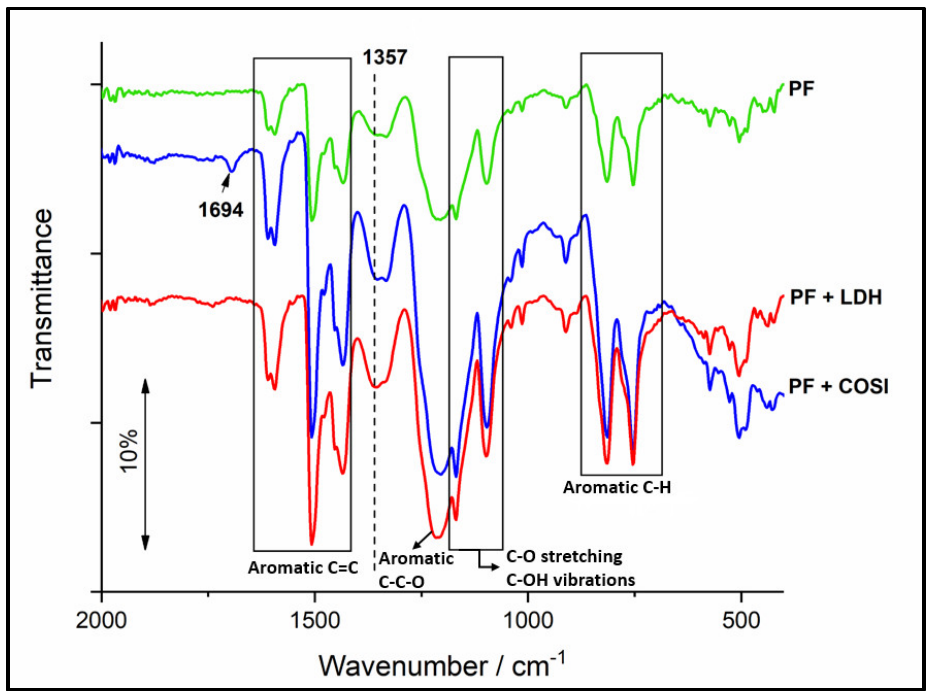
Figure 2. FTIR spectra of the unmodified resin (green curve), with addition of colloidal silica (blue curve) and modified with ZnAl-LDH (red curve).